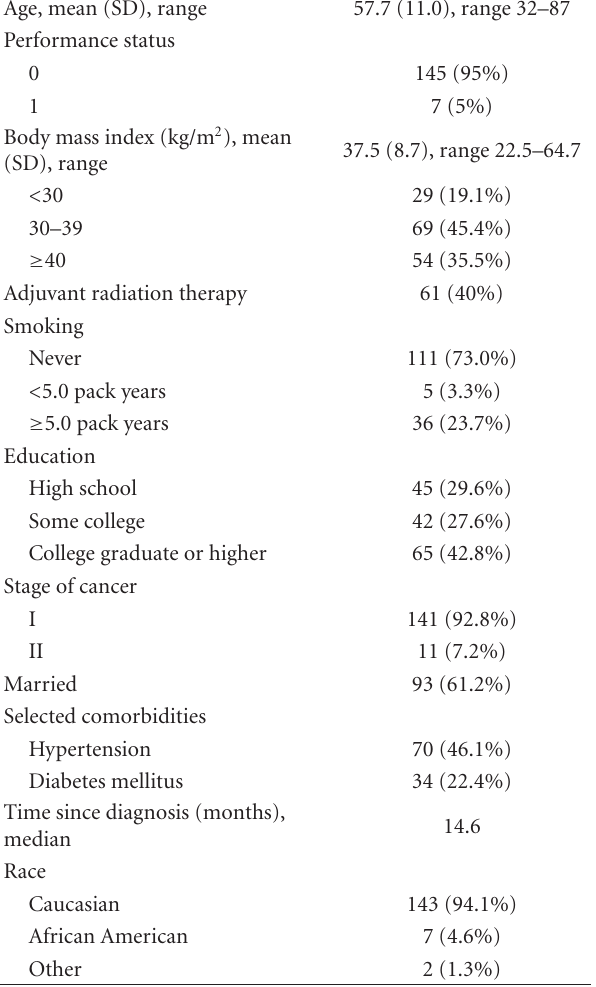
Table 1: Patient demographics and clinical variables, n = 152. Table 2: FACT-G and SF-36 means overall and by body mass index.